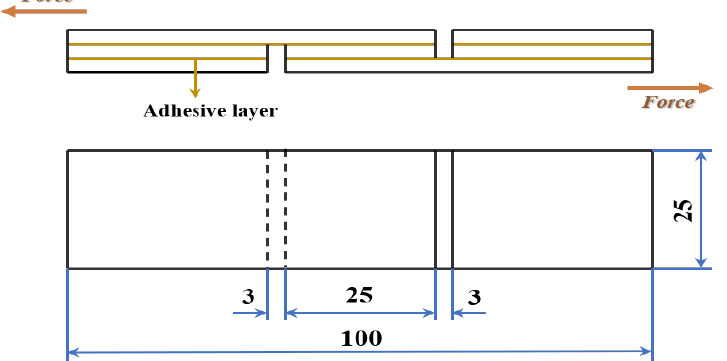
Figure 2. The diagram of shear strength test specimen (Units: mm).